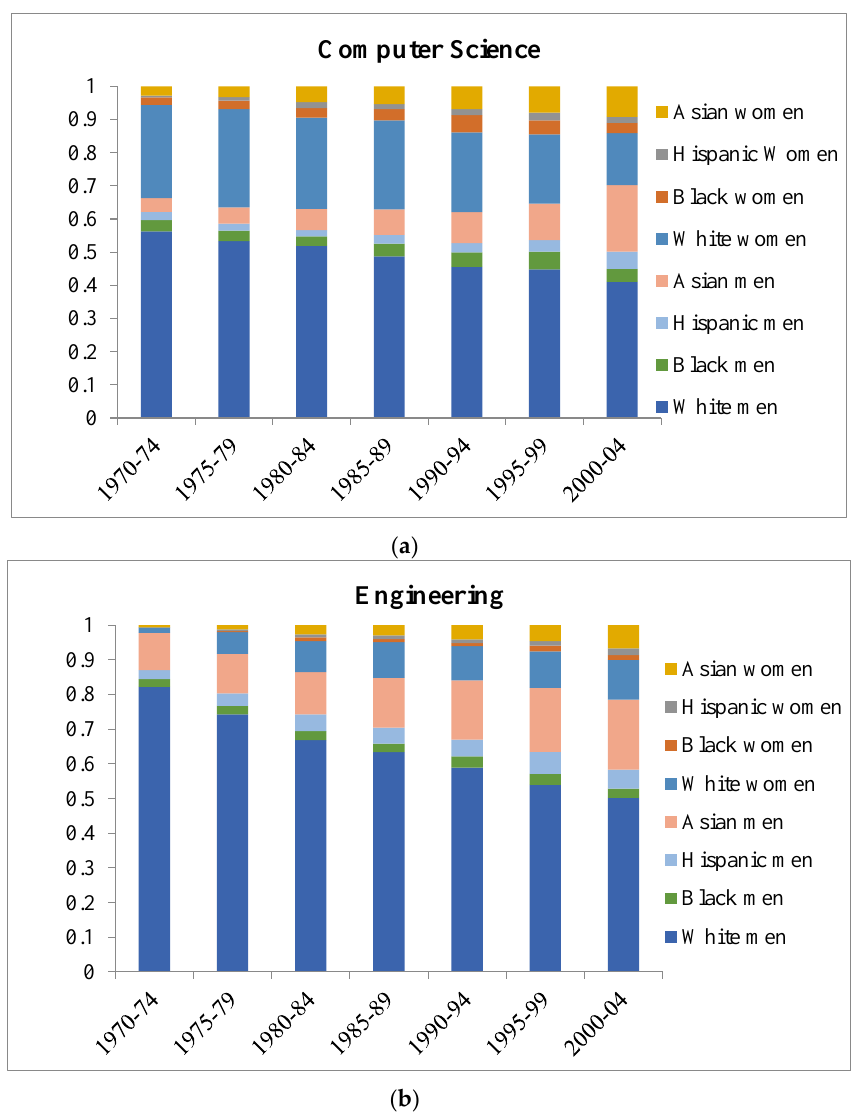
Figure 1. Race and gender distribution of computer science and engineering majors by college cohort: ( a ) Computer Science Majors; and ( b ) Engineering Majors. Source: National Science Foundation’s Scientists and Engineers Statistical Data System (SESTAT) 1995–2008. All men and women graduating with a bachelor’s degree in computer science or engineering between 1970 and 2004.